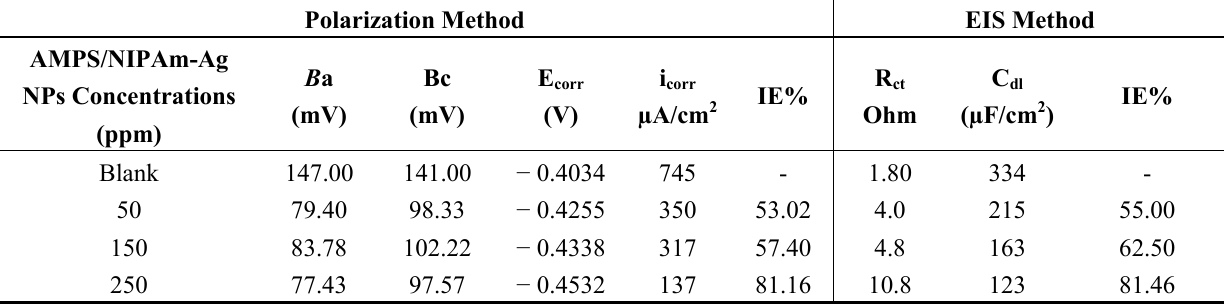
Table 1. Inhibition efficiency values for steel in 1M HCl with different concentrations of AMPS/NIPAm-Ag NPs calculated by polarization and EIS methods.